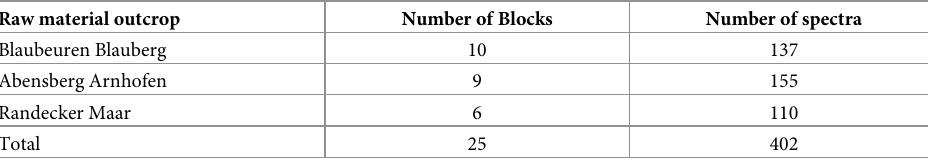
Table 1. Geological samples